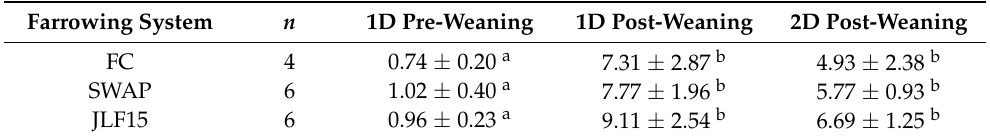
Table 4. Number of skin lesions of piglets (mean ± SE) counted on D23 (1D pre-weaning), D25 (1D post-weaning) and D26 (2D post-weaning) in three farrowing systems (FC: conventional farrowing crate; SWAP and JLF15: farrowing pens with temporary crating). Values with a different superscript ( a , b ) correspond to a significant difference ( p ≤ 0.05) between sampling days in the same farrowing system. n indicates the number of nursery pens.